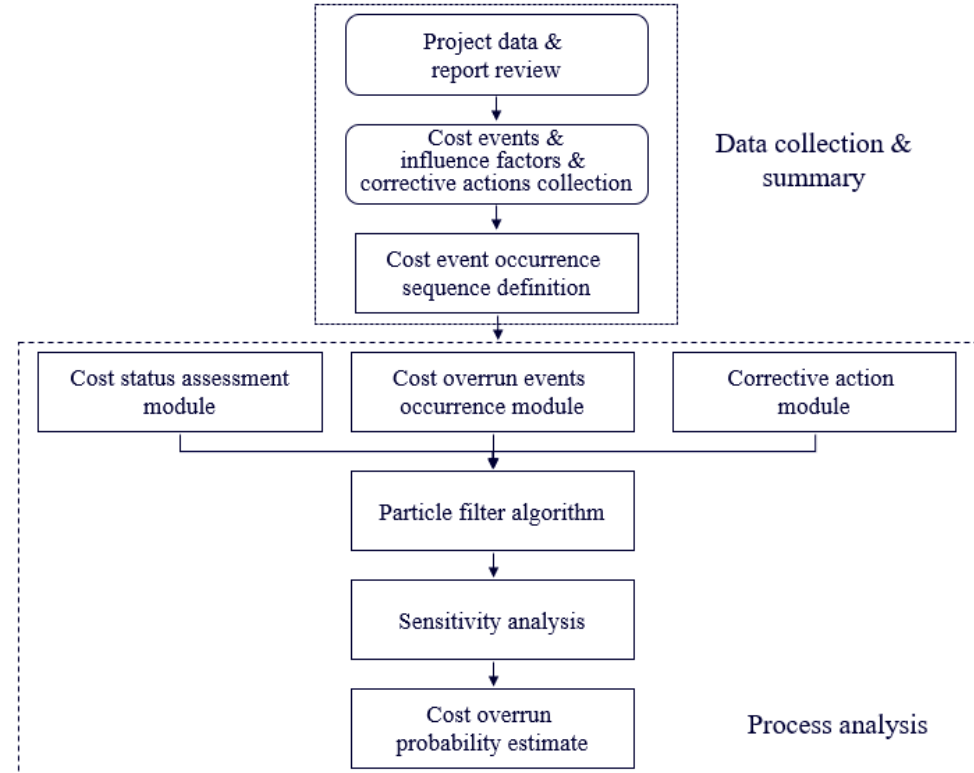
Figure 1. Overall analysis process of proposed